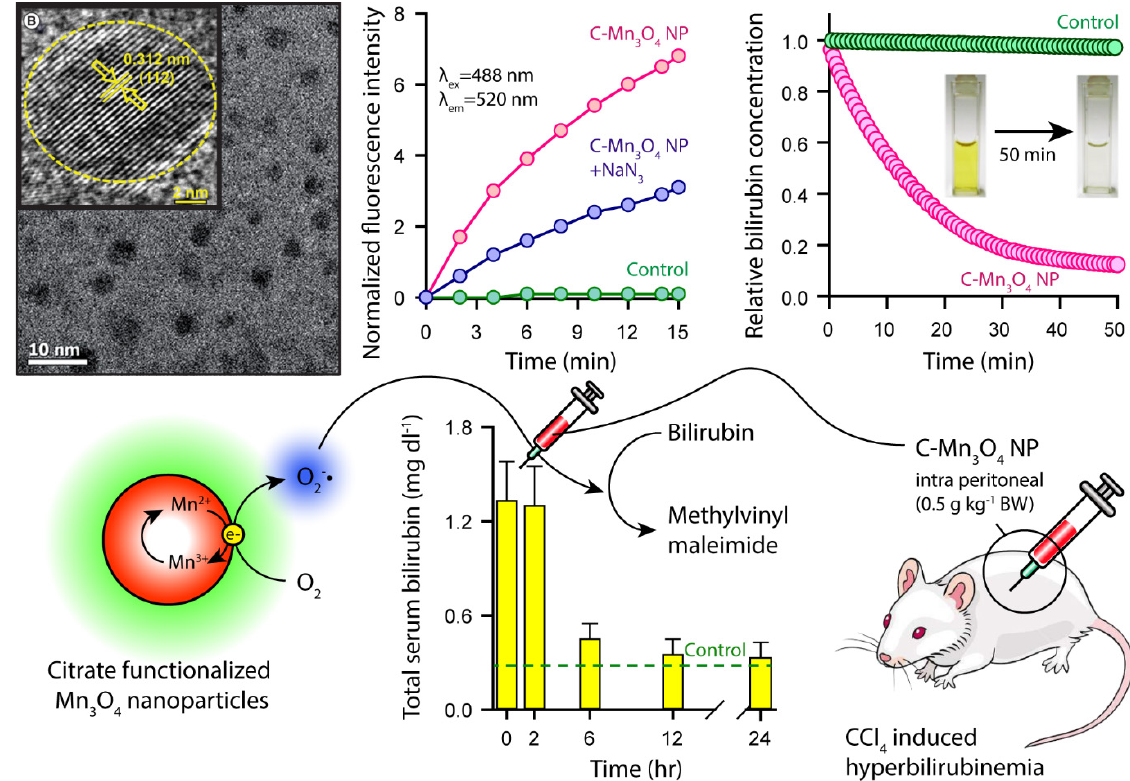
Figure 6: Generation of ROS by citrate functionalized Mn O NPs and their use in catalytic degradation of bilirubin in vivo to treat 3 4 hyperbilirubinemia (jaundice) and associated disorders. Transmission electron micrographs and high resolution transmission electron micrographs of C-Mn O NPS. DCFH activity as monitored through change in fluorescence. The degradation of bilirubin in vitro . Effectiveness 3 4 of the NPs in quick reduction (2 h) of total serum bilirubin after single dose intra peritoneal injection in hyperbilirubinemia induced Swiss albino